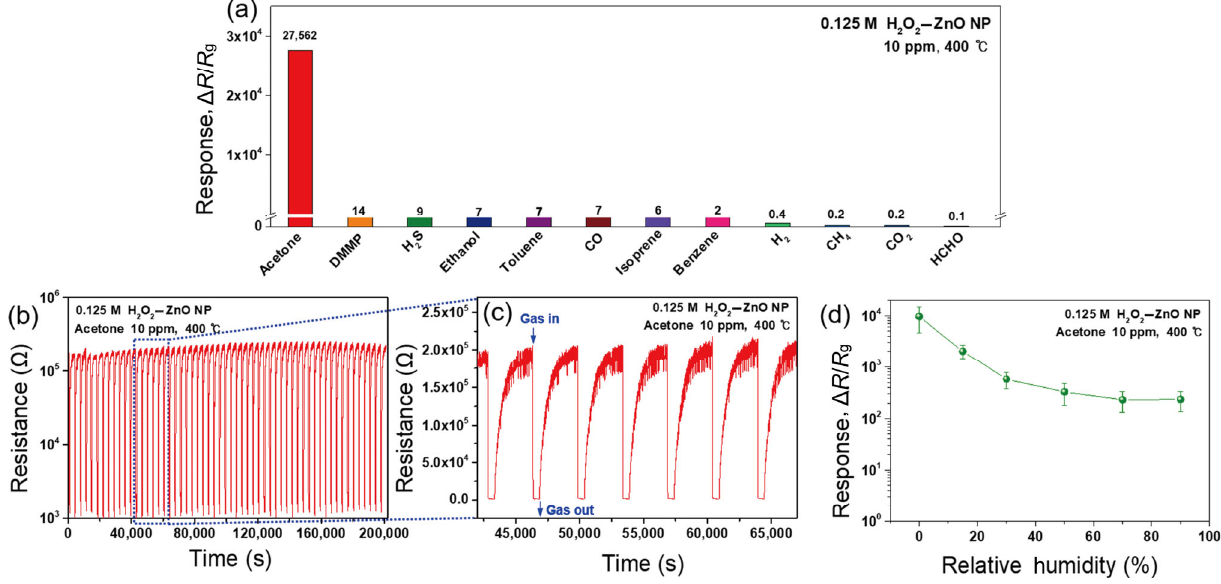
Fig. 10 (a) Sensing response of the 0.125 M H 2 O 2 treated/annealed ZnO NPs to various gases, such as acetone, dimethyl methylphosphonate (DMMP), H 2 S, ethanol, toluene, CO, isoprene, benzene, H 2 , CH 4 , CO 2 , and HCHO, at the same concentration of 10 ppm and the optimal working temperature of 400 . (b) Reliability of 0.125 M sample for detecting 10 ppm acetone over ℃ 60 cycles at 400 ; (c) magnified plot of the real ℃ -time resistance curves marked by the dotted box in (b). (d) Response change of 0.125 M sample for 10 ppm acetone under different conditions of relative humidity (RH) at 400 .